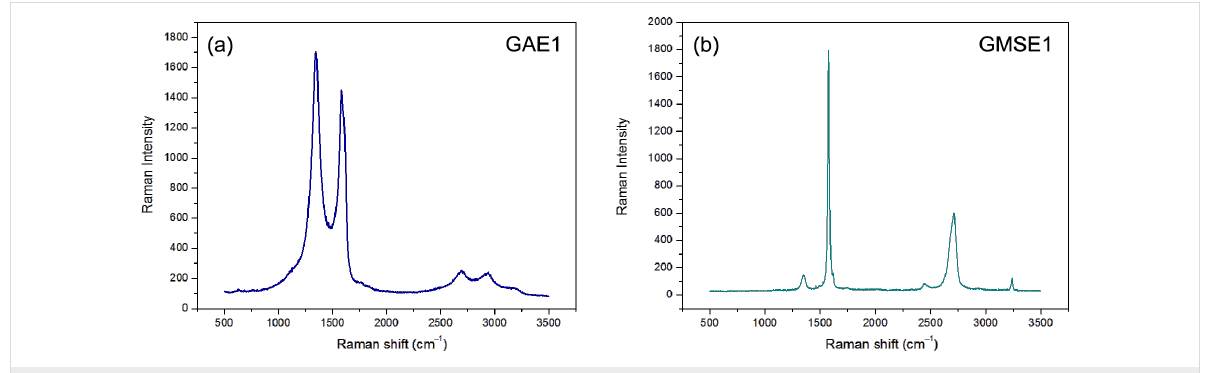
Figure 1: (a) Raman spectrum of GAE1; (b) Raman spectrum of